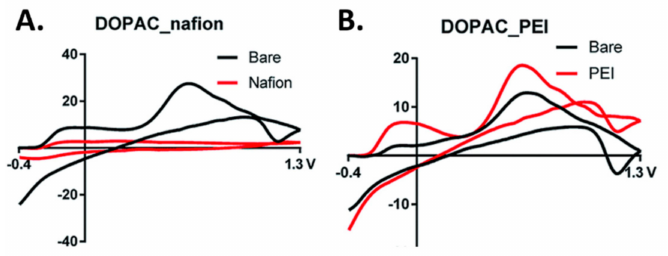
Figure 5. Fast scan cyclic voltammetry scans for 3,4-dihydroxyphenylacetic acid (DOPAC) with nafion ( A ) and polyethyleneimine (PEI) ( B ). Reprinted with permission [39].